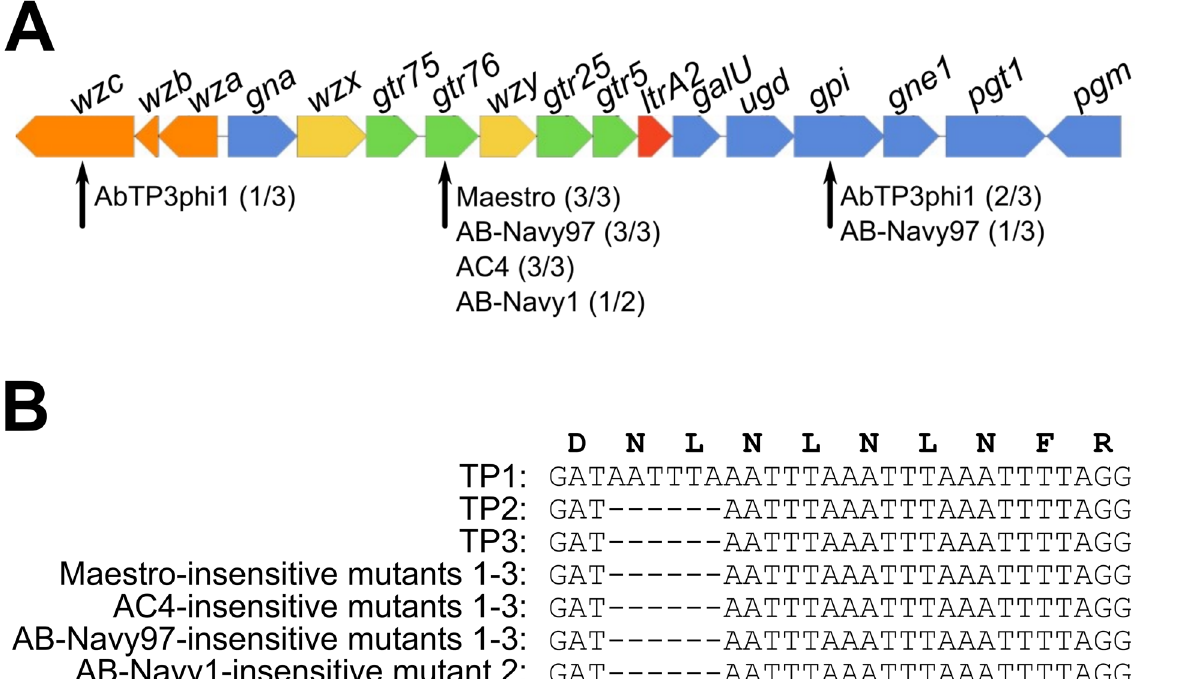
Fig. 5 Comparison of the K loci of strains TP1, TP2 and TP3, and phage-resistant mutants generated in vitro. A Diagram of the KL116 capsule locus identi fi ed in strains TP1, TP2, and TP3 as predicted by Kaptive. Genes are represented by arrows oriented in the direction of transcription. Orange arrows represent genes involved in capsule export, yellow genes are involved in repeat unit processing, blue genes are involved in simple sugar biosynthesis, green genes encode glycotransferases and the red gene codes for the initiating transferase. All genes had 100% coverage and ranged from 90 – 100% identity to the KL116 type in the Kaptive database. Defective capsule locus genes identi fi ed in in vitro-generated phage-insensitive mutants of TP1 are indicated by black arrows; numbers in parentheses after each phage name indicate what proportion of phage-insensitive mutants contained a mutation in that gene. B Nucleotide alignment of the sequences showing the six nucleotide deletion in one of the glycosyltransferases ( gtr76 ) found in multiple TP1 mutants resistant to the cocktail